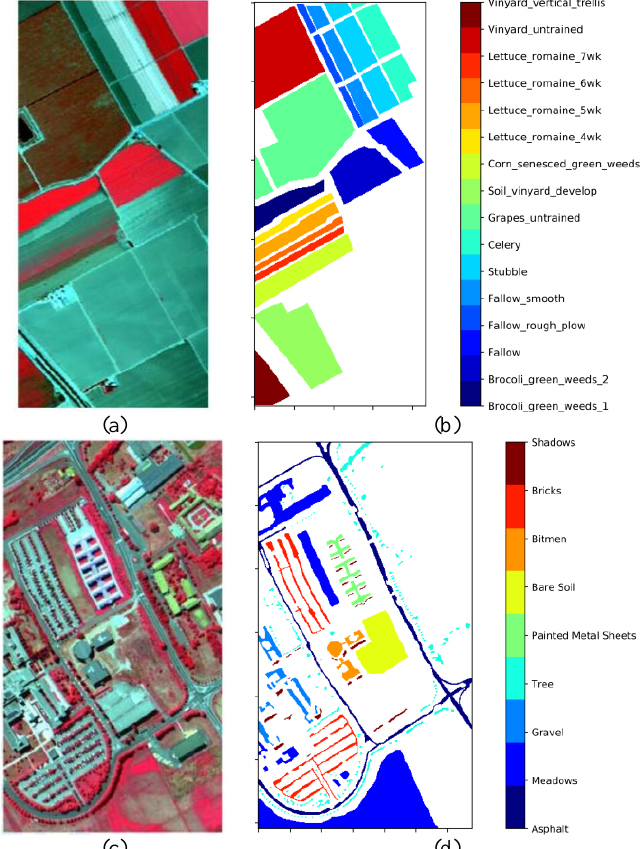
Figure 2. Salinas and PaviaU datasets (a) False color of Salinas (b) Ground-Truth of Salinas (c) False color of PaviaU (d) Ground-Truth of